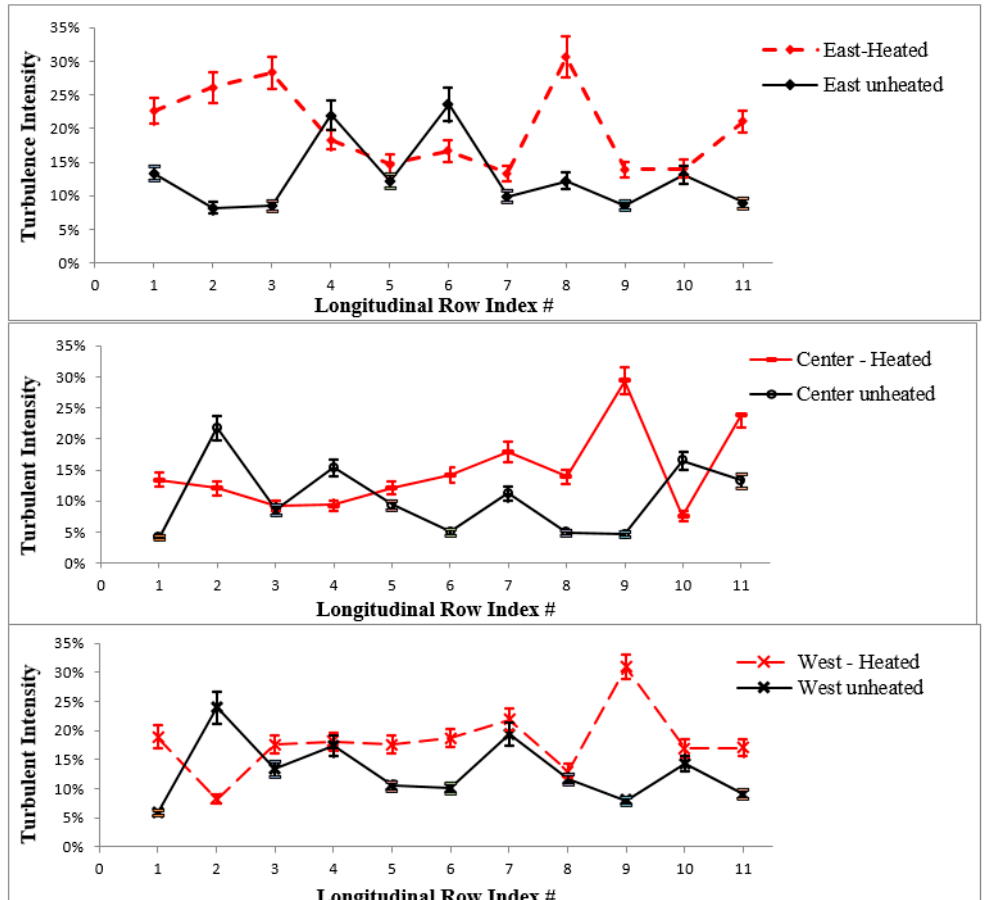
Figure 11. Turbulence intensity comparisons for heated and unheated cases in the east, center and west sides of the cabin.